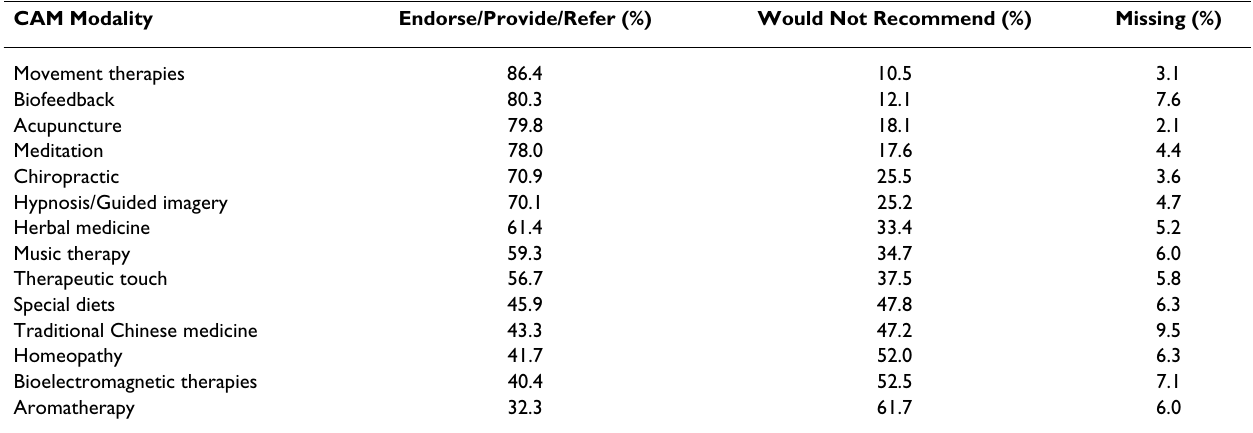
Table 3: Physician approach to CAM in practice CAM Modality Endorse/Provide/Refer (%) Would Not Recommend (%) Missing (%) Movement therapies